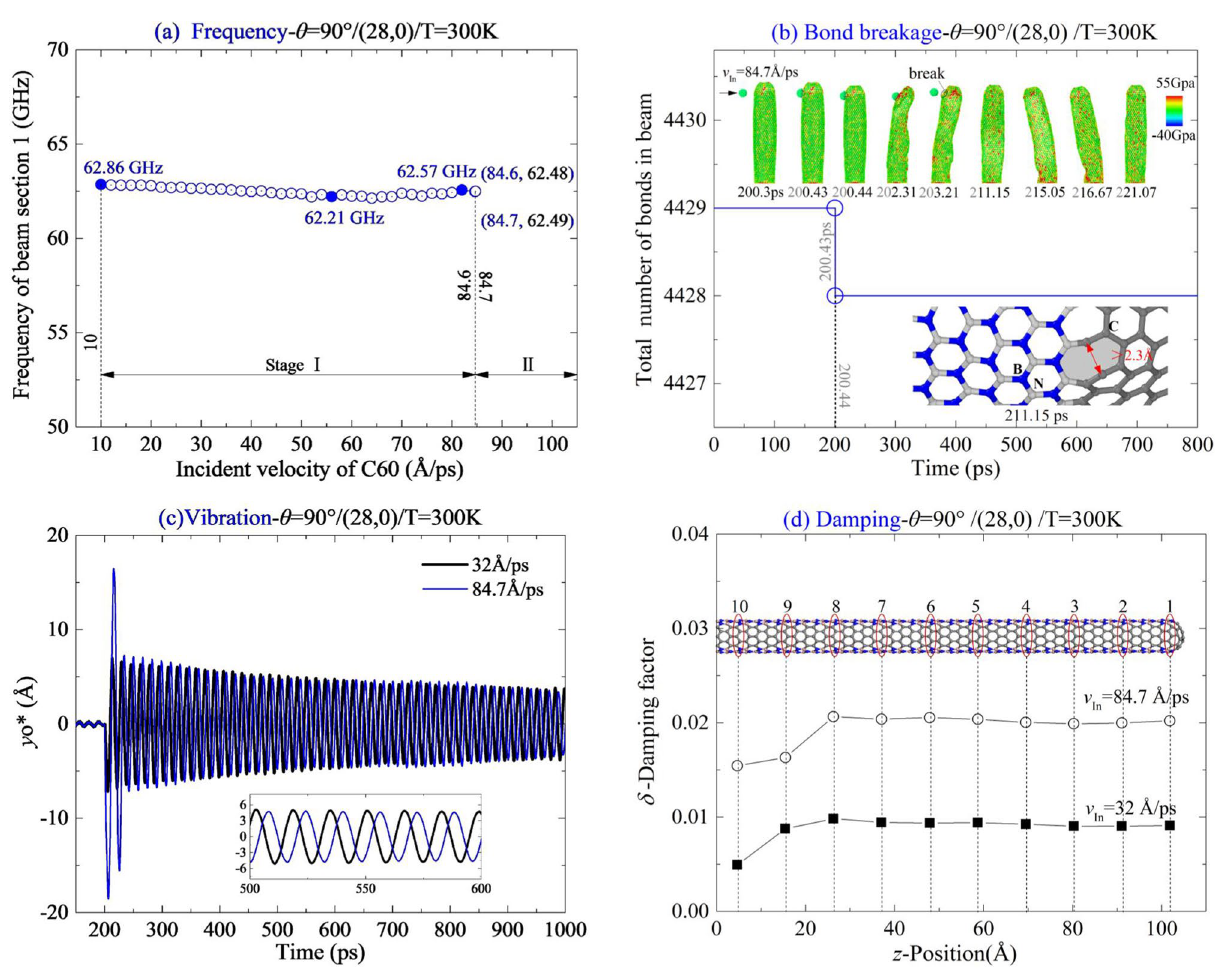
Figure 10. Vibration analysis of (28,0) nanobeam impacted by a high-speed C60 along the path of θ = 90° at 300 K. ( a ) Natural frequencies of the beam impacted by the C60 with different incident velocities. ( b ) Damping factors of beam sections. ( c ) Vibration curves of yo*,when v In = 32 beam